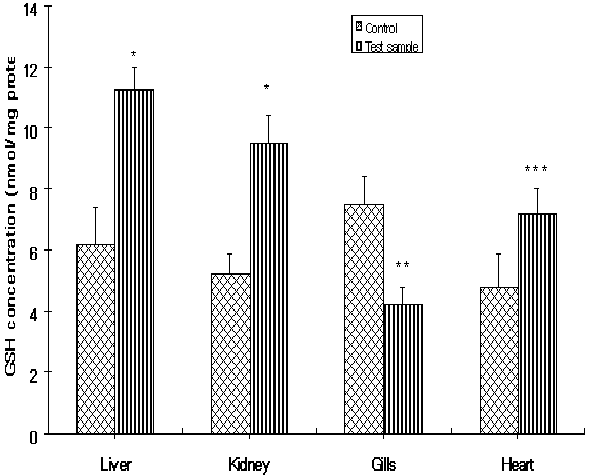
Figure 4: The levels of glutathione (GSH) in the livers, kidney, Gills and heart of Clarias gariepinus from the Ogun River and Agodi farm. Values are mean ± SD of 10 fishes. Significantly different from control,* p<0.001;** p<0.01; ***p<0.05.